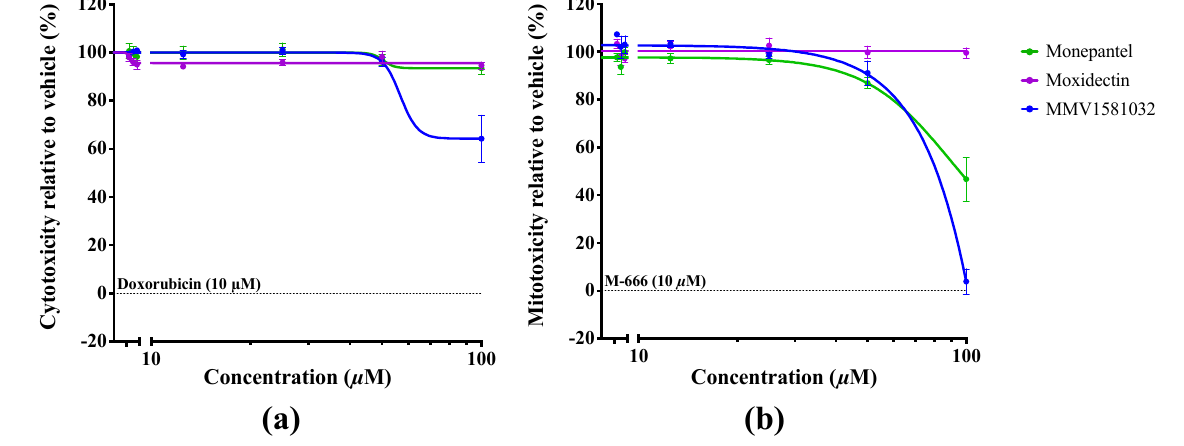
Figure 4. Toxicity assessment of MMV1581032, moxidectin and monepantel on HepG2 human hepatoma cells with reference to two positive controls; doxorubicin (cytotoxic) and M-666 (mitotoxic). A cell-viability assay was employed to estimate ( a ) the half-maximal cytotoxic concentration (CC 50 ) and ( b ) the half-maximal mitotoxic concentration (MC 50 ) after 48 h of incubation with compound. Crystal violet staining was utilised to measure the absorbance (595 nm) of treated cells compared to the negative control (100% cell viability) and baseline-corrected using respective positive controls. Data points represent one experiment conducted in triplicate; mean ± standard error of the mean (SEM).